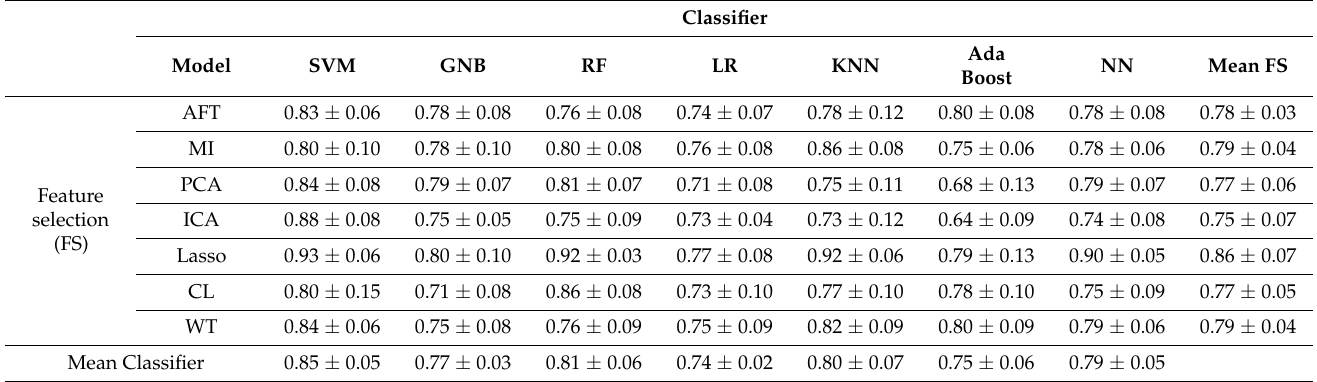
AUC = area under the receiver operator characteristic curve, SD = standard deviation, AFT = ANOVA F- test, MI = mutual information, PCA = principal component analysis, ICA = independent component analysis, Lasso = least absolute shrinkage and selection operator, SVM = support vector machine, GNB = Gaussian naive Bayes, RF = random forest, LR = logistic regression, WT = Wilcoxon test, NN = neural network, KNN = k-nearest neighborhood, CL = clustering, AdaBoost = adaptive boosting.